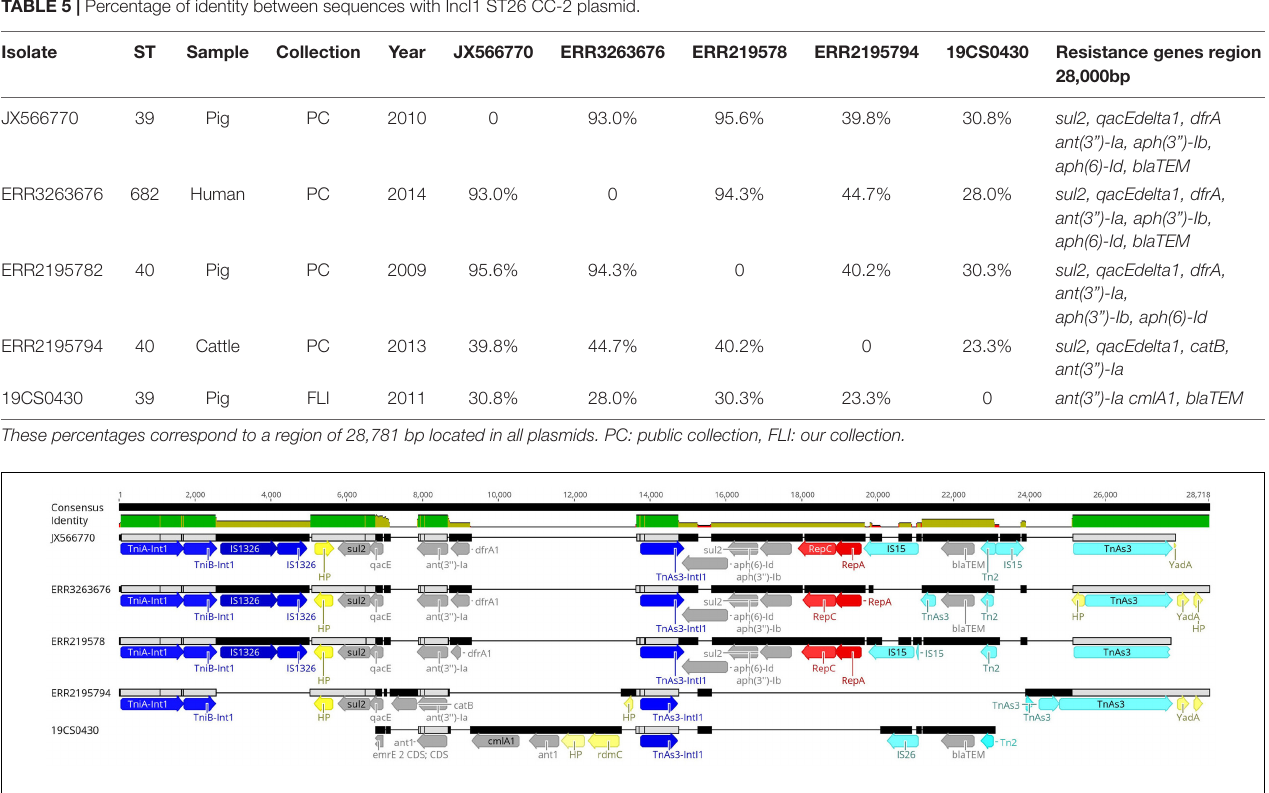
FIGURE 1 | Multiple alignments of plasmid sequences belonging to the IncI1 ST26 CC-2 in the 28,781 bp region. Dark blue: Integron genes, yellow: Hypothetical protein gene (HP) and other genes, gray: Antimicrobial resistance genes, red: Plasmid replicase gen, light blue: other mobile elements like transposons (Tn) and insertion islands